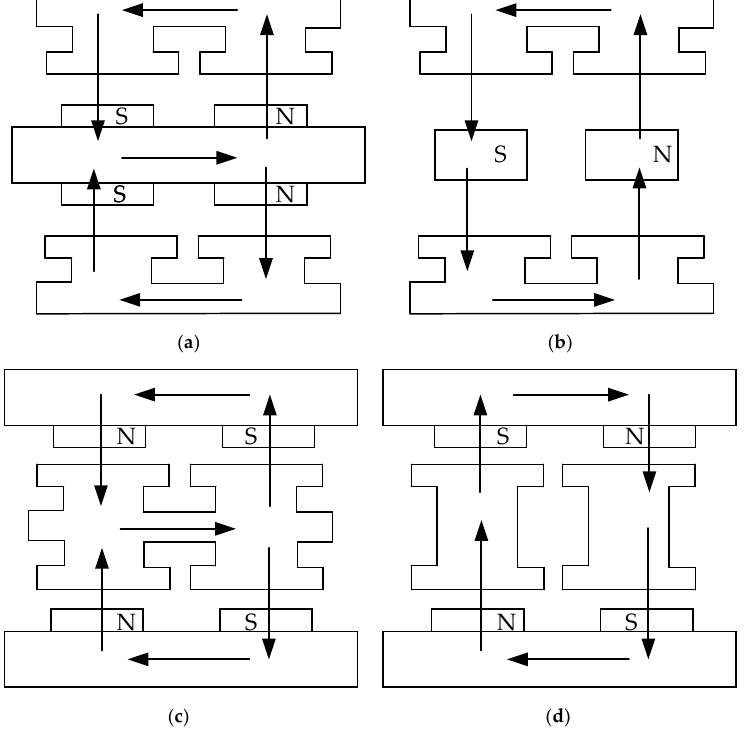
Figure 1. Different topologies of the axial flux permanent magnet machine (AFPMSM). ( a ) Double- stator single-rotor (DSSR) with surface-mounted PM, ( b ) DSSR with interior PM, ( c ) toroidally wound internal stator (TORUS), and ( d ) yokeless and segmented armature (YASA).